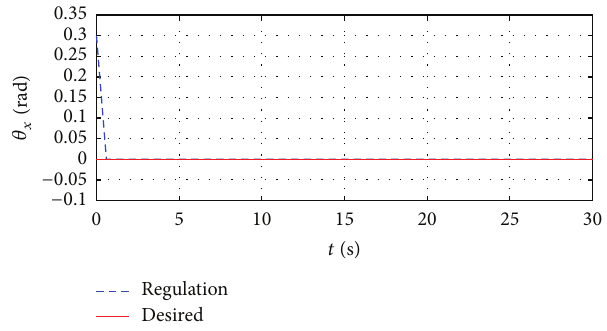
Figure 12: Regulated theta in 𝑥 direction in 30 seconds. Theta in 𝑥 direction, the angle of ball from 𝑥 direction, is stabled after about 0.6 sec.